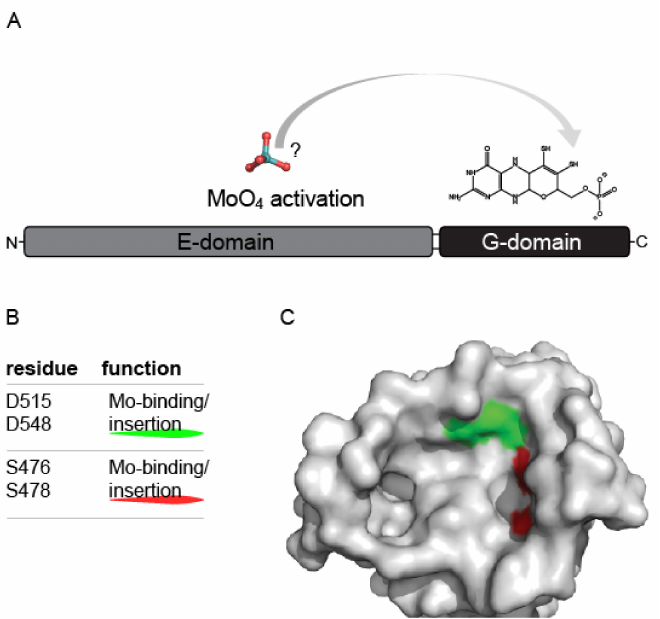
Figure 4. The 2003 model for molybdenum insertase functionality. Schematic representation of the 2003 model of Mo-insertase functionality. ( A ) Cnx1 E-domain organization (see Figure 3 for comparison) with the proposed functions annotated as follows: The Cnx1 E-domain was suggested to provide a to that time unidentified, activated molybdate species (indicated by an?, [40]), while the Cnx1 G-domain was suggested to bind molybdopterin (MPT) and to insert the activated molybdate species in the MPT dithiolene, thus yielding the molybdenum cofactor (Moco). ( B ) Catalytically relevant residues identified for the Cnx1 G-domain and their proposed functions [42,43]. ( C ) Active site view of the gephyrin G-domain (PDB entry: 1JLJ, [43]). Monomer A is shown in surface representation. The positional homologs to the Cnx1 G-domain residues tabulated in ( B ) are colored as indicated in ( B ). The view of the active site and the coloring of gephyrin G-domain Asp residues 61 and 94 (homologs to Cnx1 G-domain D515 and D548 was adapted according to [43]. Figure panel C was created with PyMOL